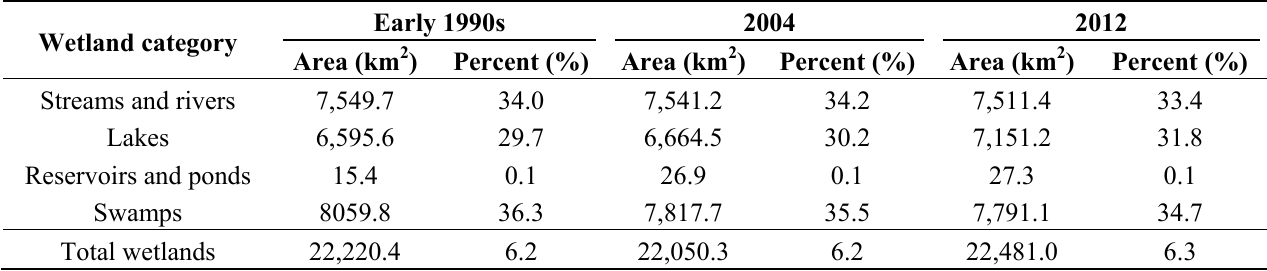
Table 2. Wetland area changes since early 1990s in the TRH